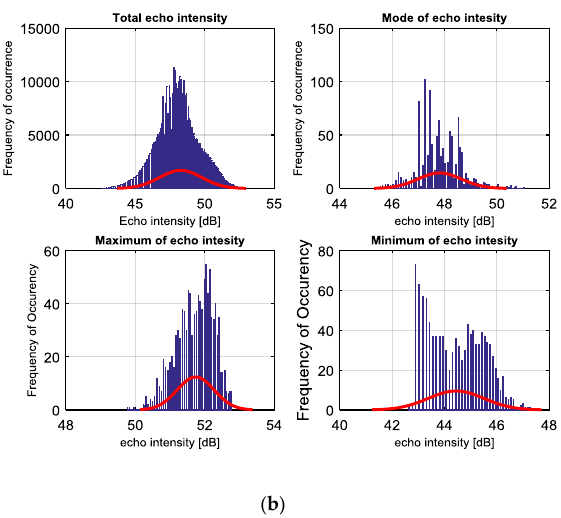
Figure 9. Post-analysis of echo intensity (acoustic backscattering intensity) data acquired using a DBS system for ( a ) propeller and ( b ) waterjet thruster. Distribution of the total volume backscattering, mode of echo intensity that represents background noise, maximum that represents target, and minimum of echo intensity that represents both the cavitating flow and noise. The red lines show the filtering distribution.